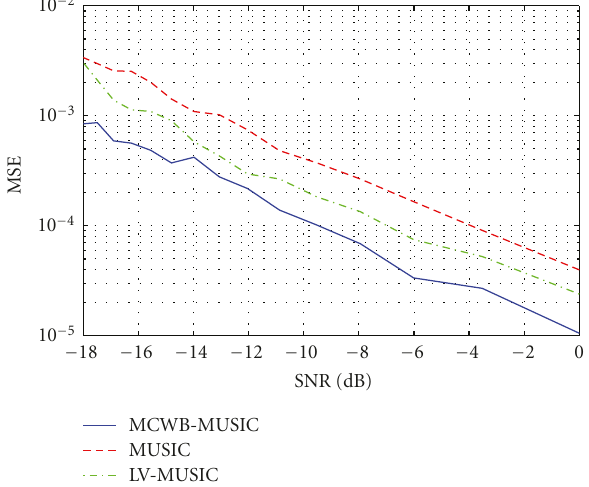
Figure 5: Comparison of DOA estimation error for various methods. (dotted line: Classical MUSIC; semidotted line: LV- MUSIC; plain line: MW-MUSIC).